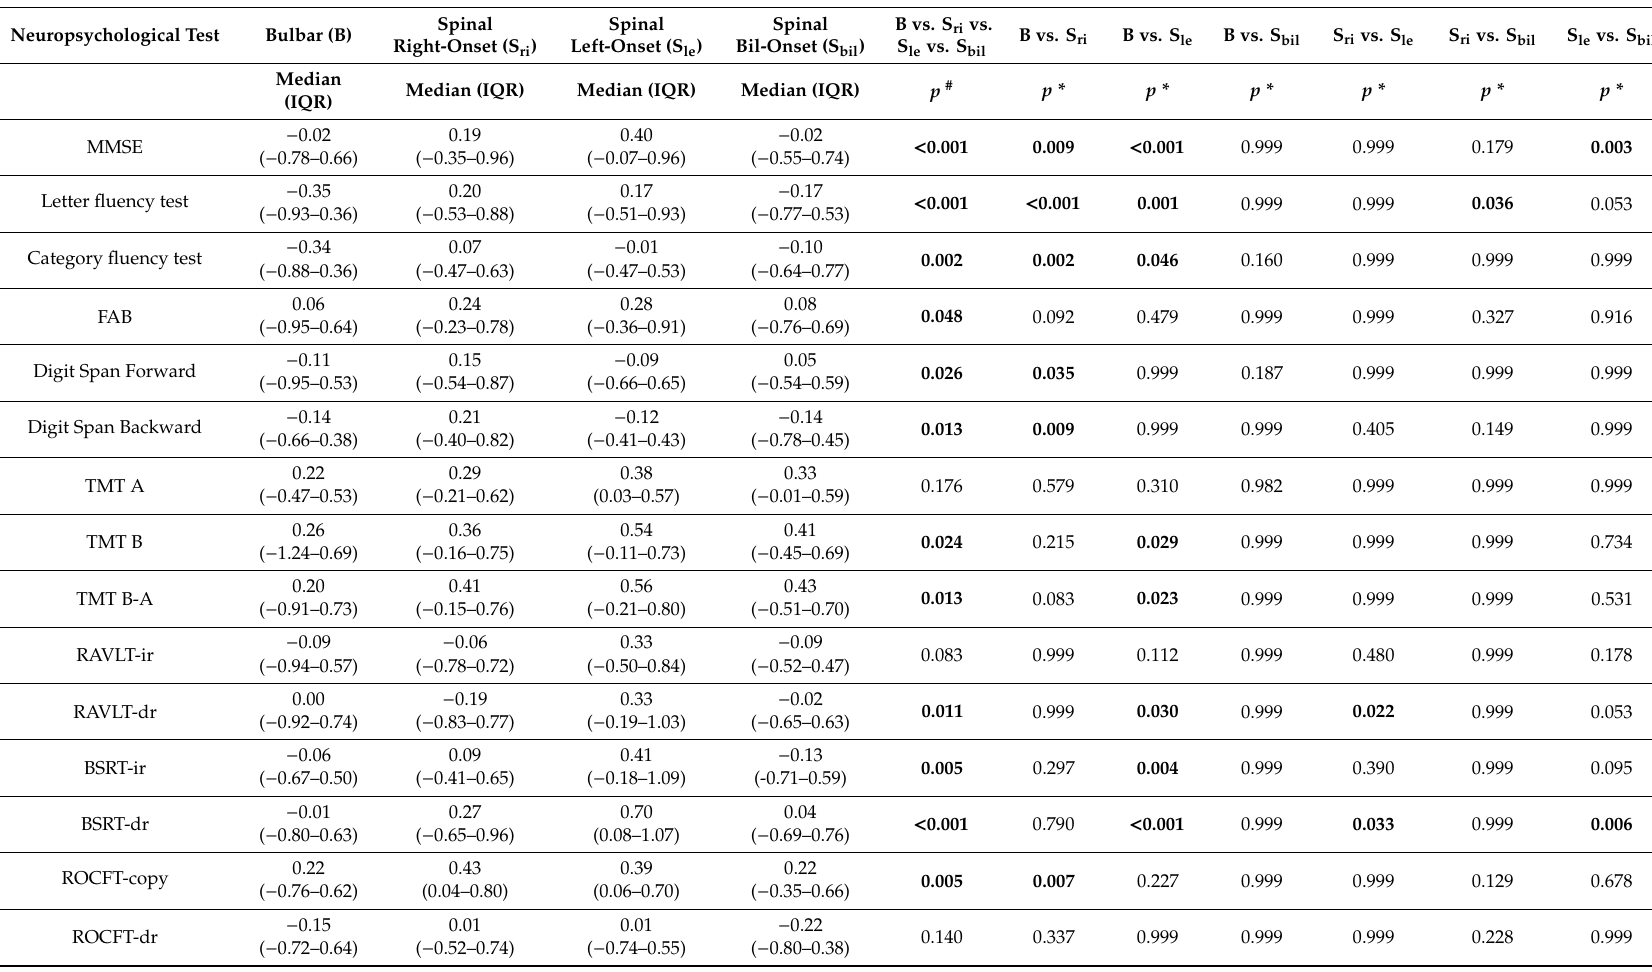
Table 2. Z -score comparison according to site and side of onset (bulbar onset, B vs. right-side spinal onset, S ri vs. left-side spinal onset, S le vs. bilateral spinal onset, S bil ) for di ff erent neuropsychological